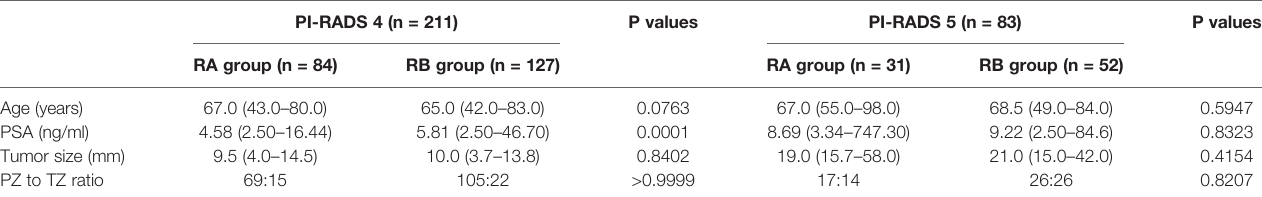
TABLE 1 | Patients ’ demographics.